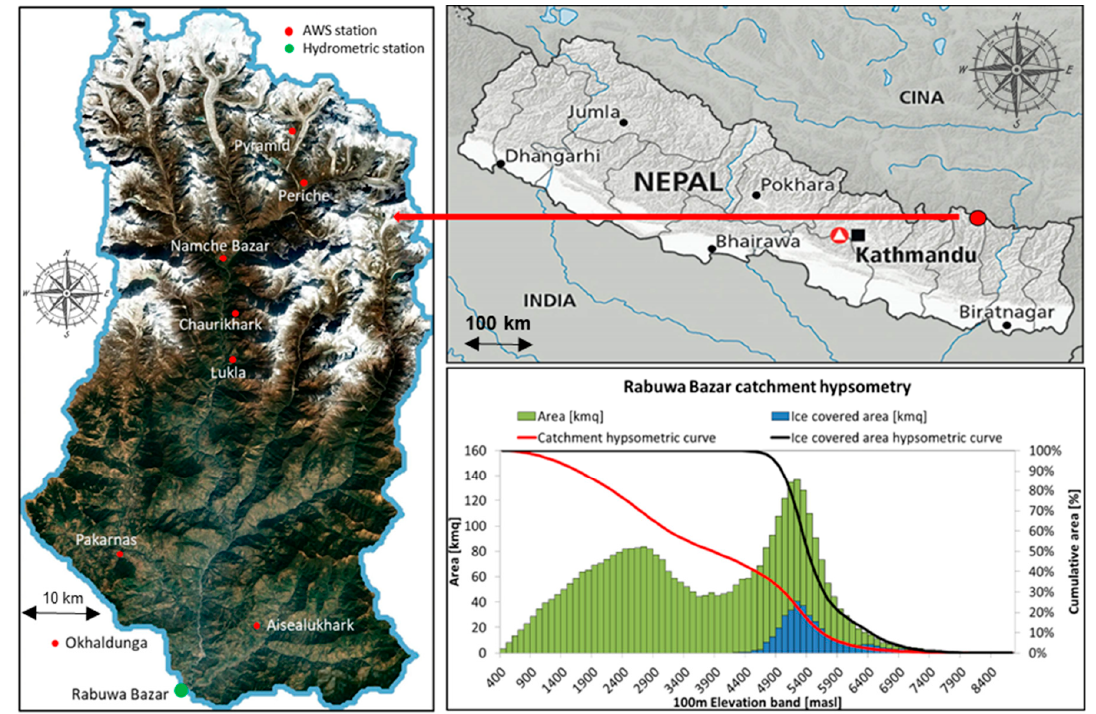
Figure 1. Case study area. Dudh Koshi basin location, and topography. Weather and hydro stations used in the study are reported. AWS = Automatic Weather Station. Topography was extracted from ASTER GDEM, resampled at 300 m × 300 m.